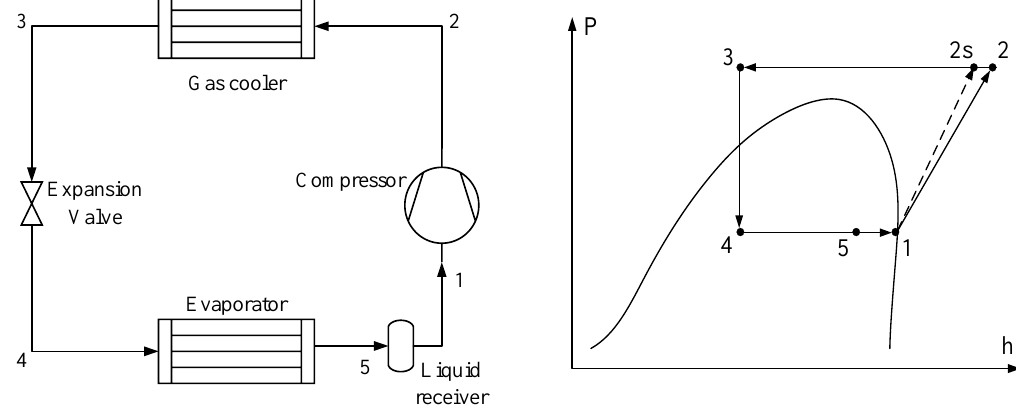
Figure 1. Schematic diagram of a basic transcritical CO 2 refrigeration cycle (model 1: base cycle).